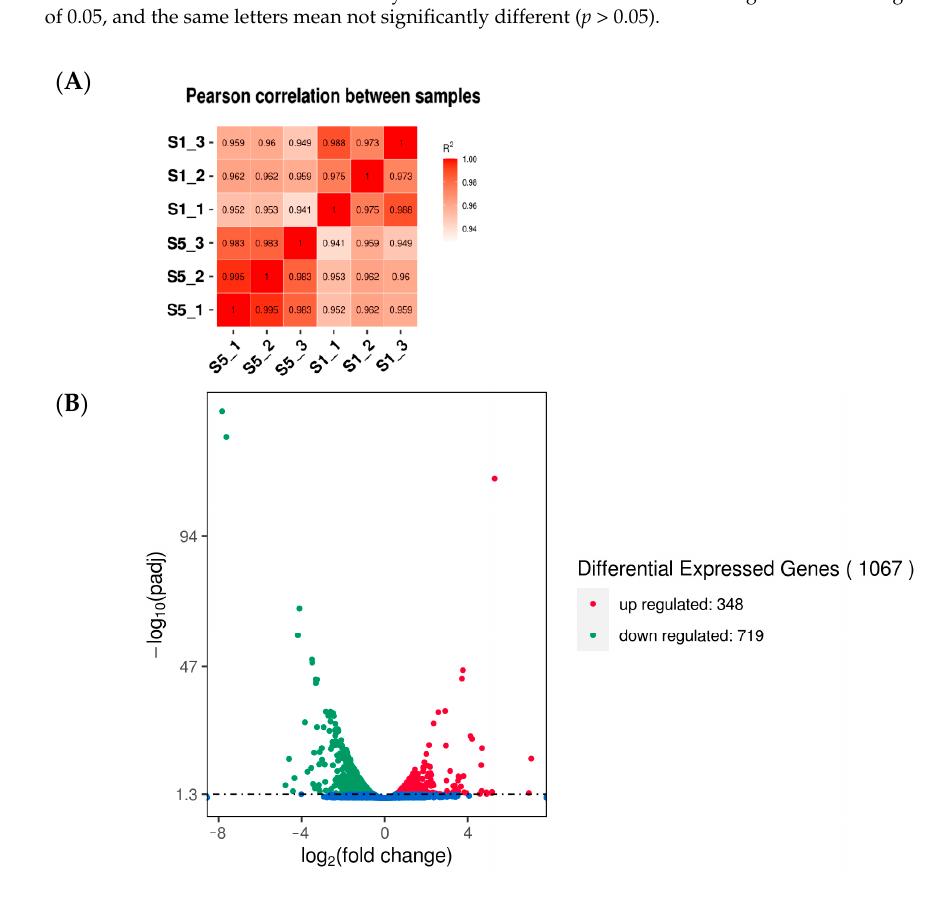
Figure 4. Correlation and DEGs analysis between strain S1 and S5. ( A ) Pearson correlation analysis between samples of strain S1 and S5. “_” indicated three biological duplications in each group. ( B ) DEGs between strain S1 and